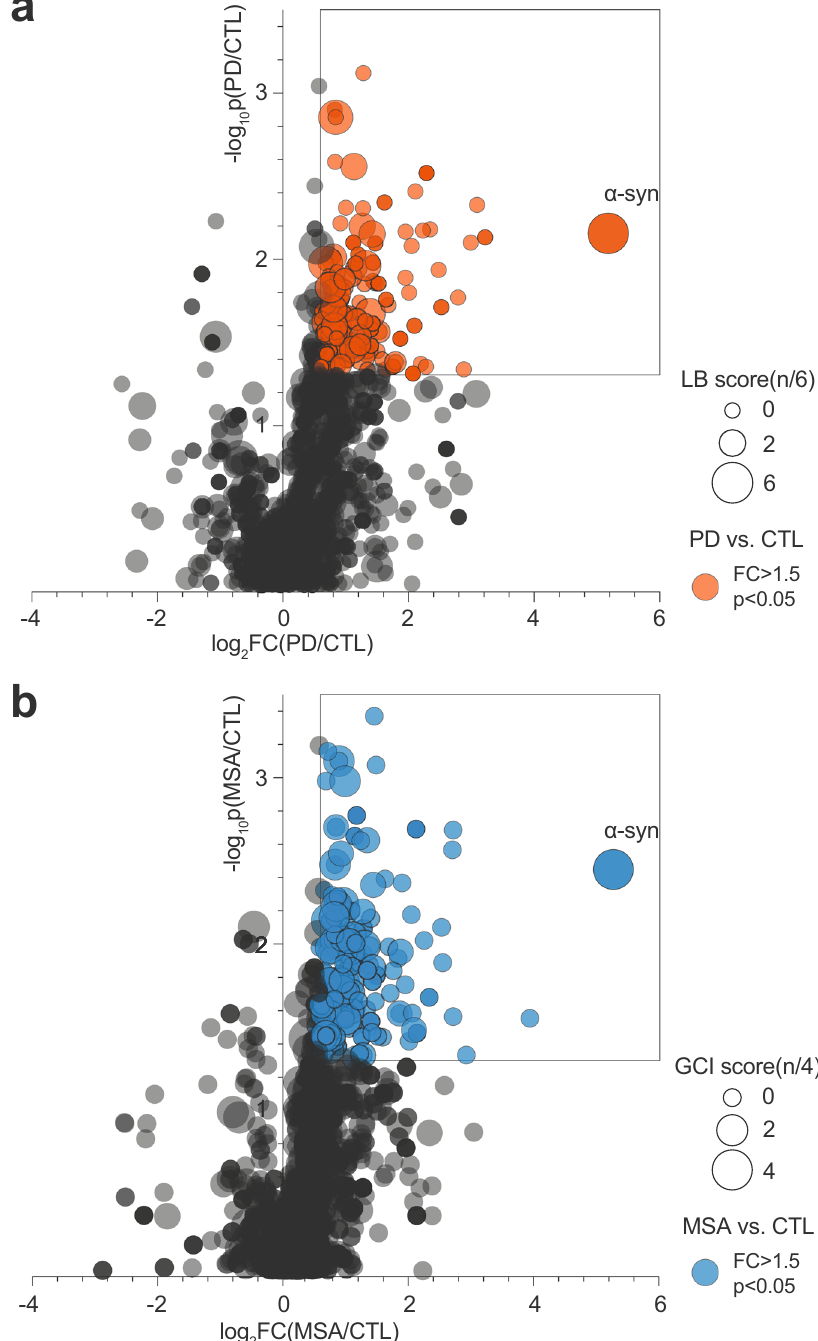
Fig. 2 Prime enrichment in alpha-synuclein and unidenti fi ed insoluble proteins in PD and MSA Sarkospin pellet fractions. Bubble volcanos charts representing mass spectrometry analysis of the protein content of all n = 9 pellets. Each of the 1022 master proteins identi fi ed in the present proteomic study is plotted as a circle positioned upon the fold change (log 2 FC) and statistical signi fi cance ( − log 10 p Value) of its enrichment in PD ( a ) and MSA ( b ) insoluble pellets as compared to controls, respectively. Fold changes represent ratios of normalized abundance of a protein (normalized between individuals to the abundance of all proteins) between disease and control groups, with p values of the respective multiple t-tests ran on n = 3 biologically independent human brain samples per group. Colored bubbles indicate proteins signi fi cantly enriched in disease (red for PD, blue for MSA) vs. control pellets, with a FC > 1.5 and p < 0.05. A total of 206 are found signi fi cantly enriched in any of the two synucleinopathy groups, with 130 proteins for PD ( a , red) and 160 for MSA ( b , blue). Bubbles are sized upon their respective LB or GCI scores from mass spectrometry analysis in the literature. These scores refer to the number of articles (6 for LBs, 4 for GCIs) identifying this speci fi c protein in the respective pathological inclusions out of ten articles 3,5,6,20,21,23 – 25,27